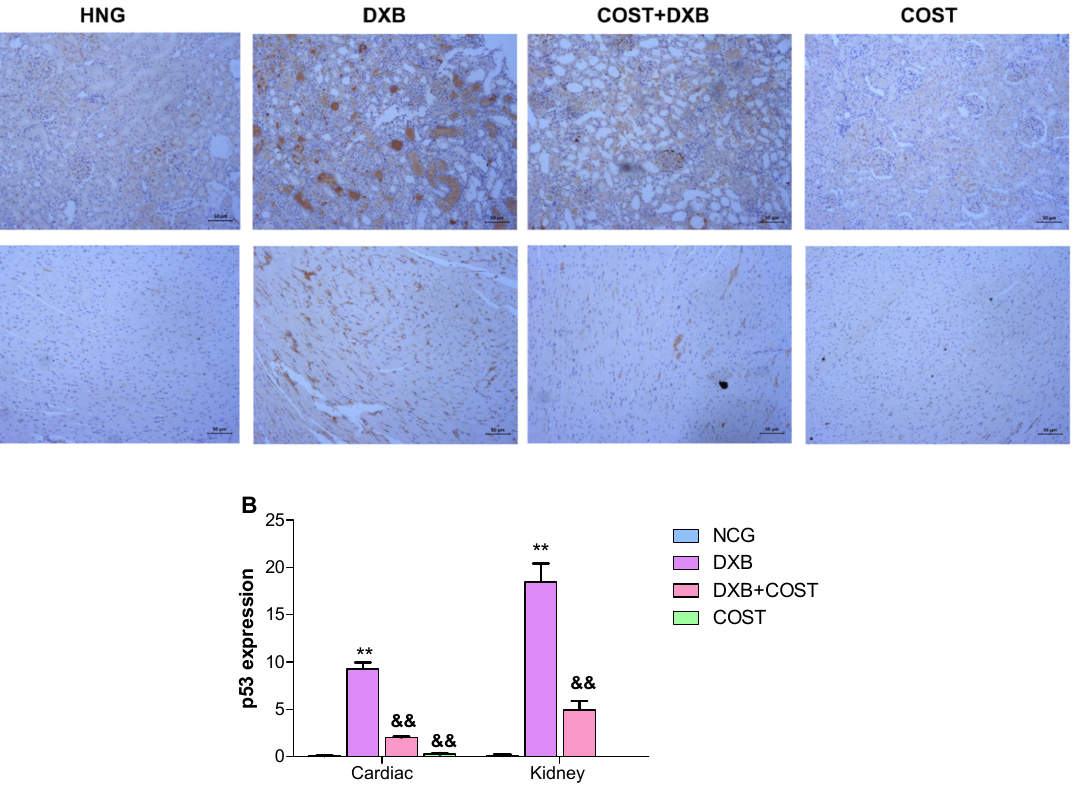
Figure 7. ( A ): Photomicrography of kidney and heart tissues showing expression of p53 in all experimental groups, ( B ): quantification of p53 immunohistochemical expression in kidney and heart tissues. ** Statistically significant ( p < 0.01) compared with NCG and COST groups. && Statistically significant ( p < 0.01) compared with DXB group.